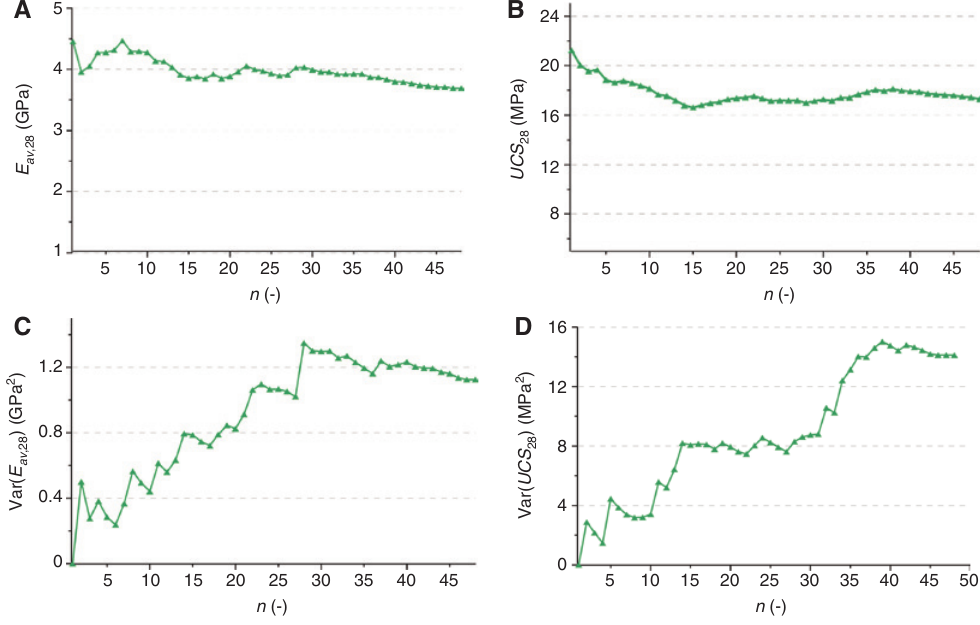
Figure 13: The results obtained for mortar specimens of diameter D = 28 mm. (A) the mean value of Young modulus, (B) the mean value of UCS , (C) variance of Young modulus and (D) variance of UCS , as a function of the number of performed tests n